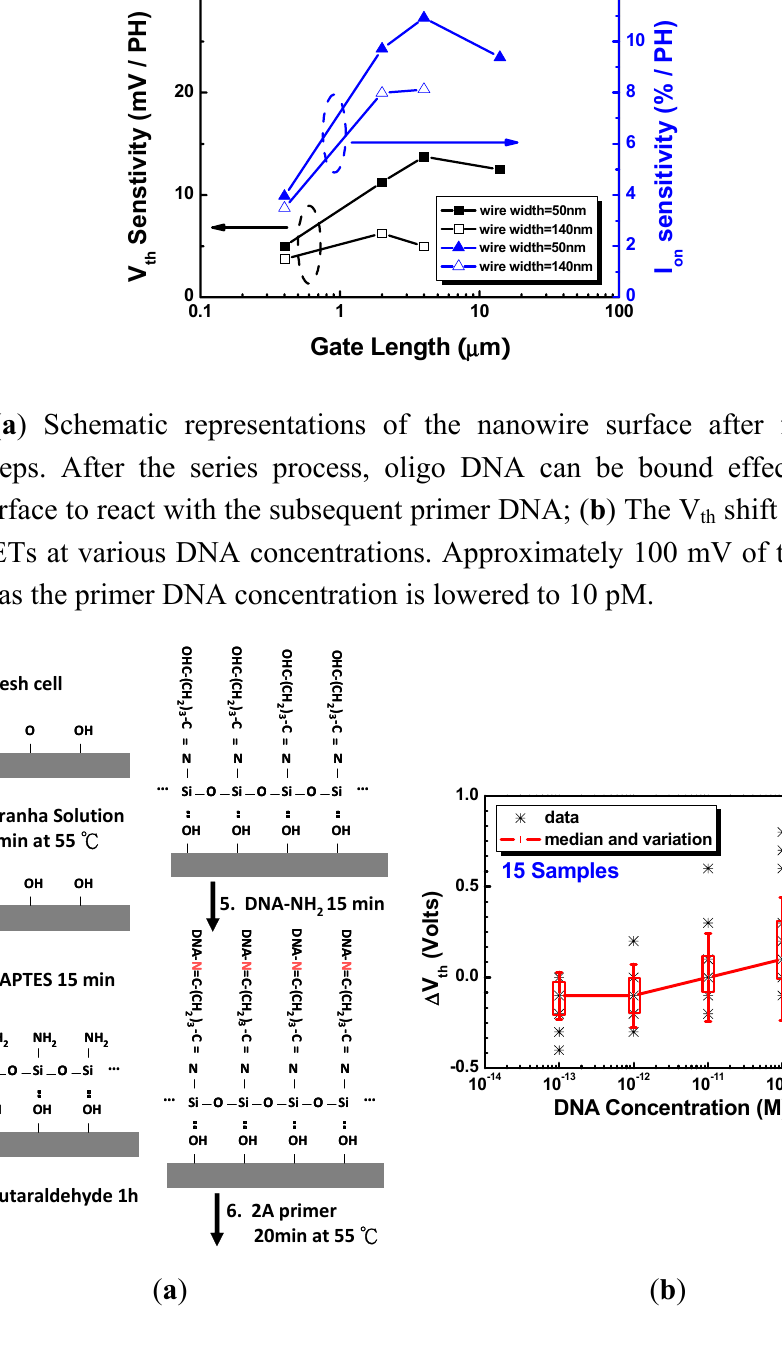
Figure 5. The pH sensitivity of poly-Si nanowire FETs sensor responses for various nanowire geometries.